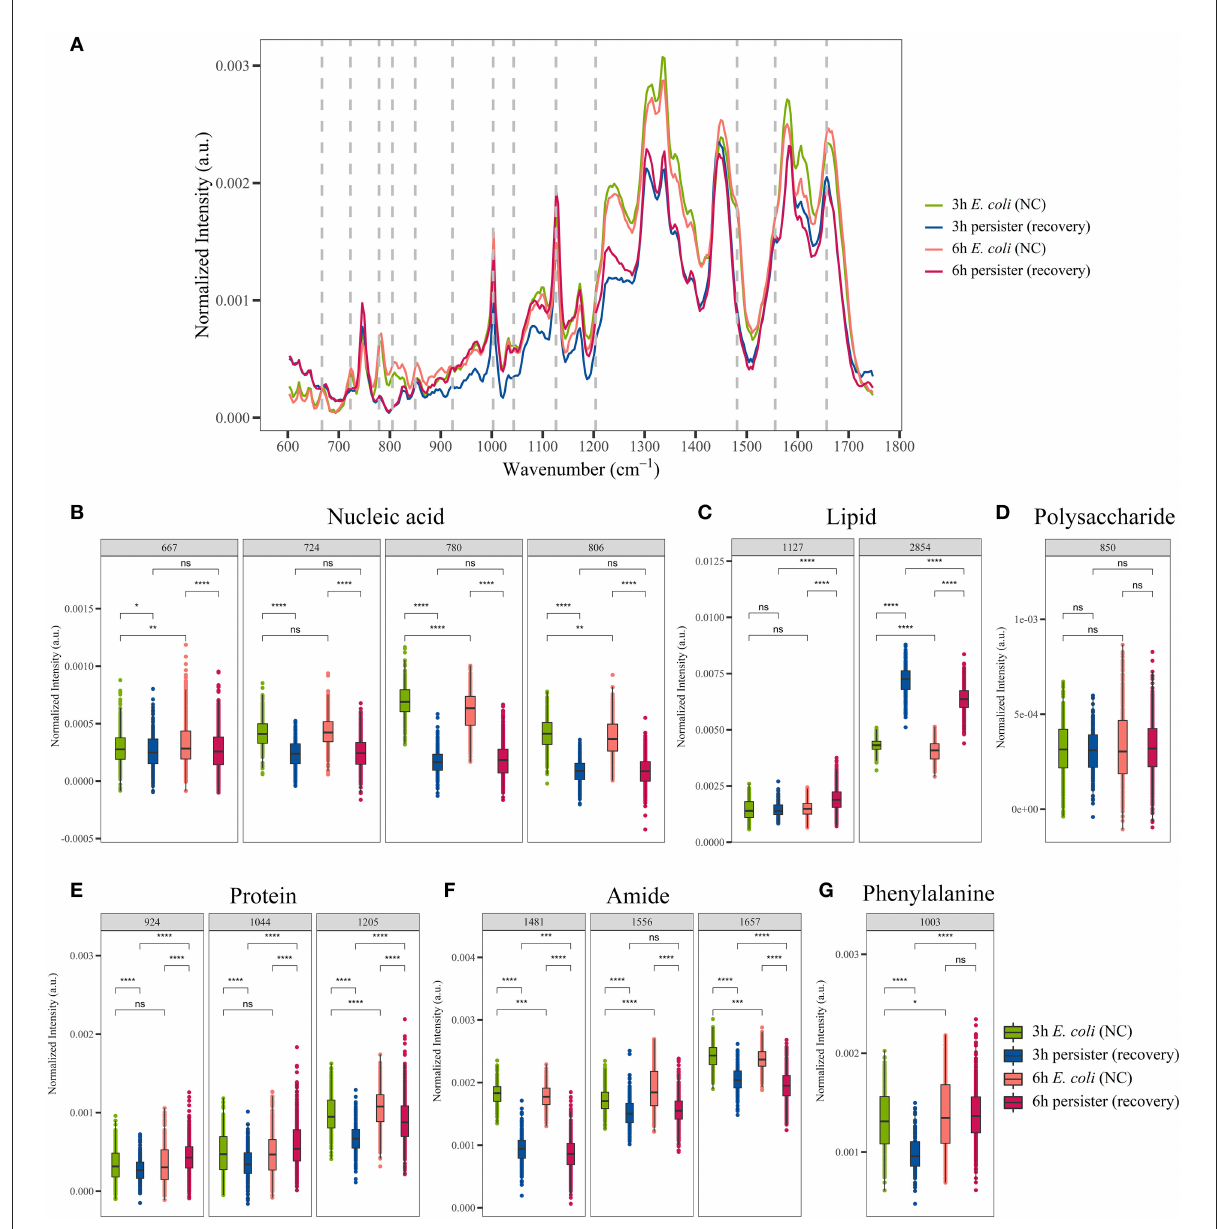
FIGURE5 Single-cell Raman spectra of E. coli persisters during resuscitation. Overnight planktonic-cultured E. coli (12h) was 1:100 diluted into fresh LB broth and further cultured for 3 and 6h, followed by ampicillin treatment (100 µ g/mL, 32 × MIC) for 4h. Then, the persisters were washed two times with Milli-Q water and further cultured in fresh LB broth without the drug for another 4h. Single-cell Raman spectra were obtained afterward. (A) Mean spectra of E. coli and persisters, normalized by the sum of fingerprint area from 600 to 1,750 cm − 1 . (B–G) Intensity of Raman bands for major cellular components: nucleic acid (B) , lipid (C) , polysaccharide (D) , proteins (E) , amide (F) , and phenylalanine (G) . N > 50 for each group. ns, no significance; NC, E. coli cells without ampicillin treatment; * P < 0.05; ** P < 0.01; *** P < 0.001, **** P <